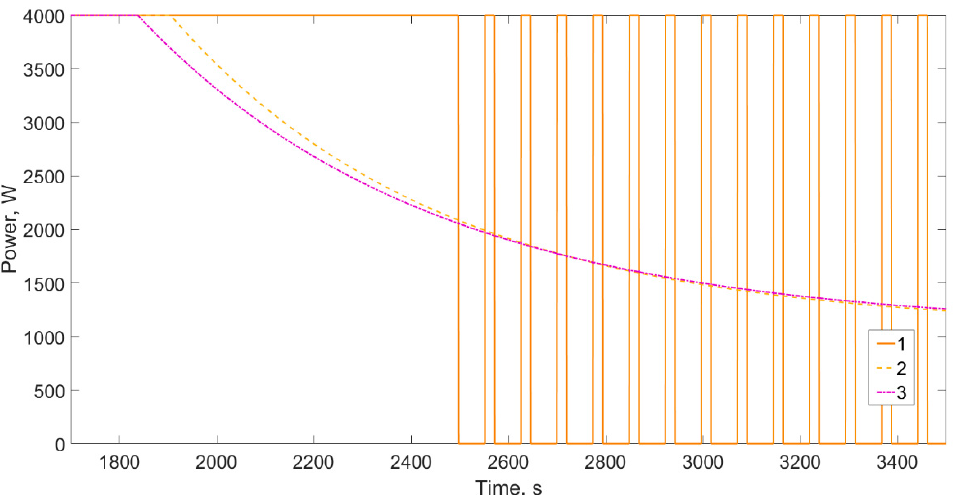
Figure 12. Course of the control signals from the different controllers for the isolated time interval (no noise): 1—relay, 2—PID and 3—I-PD.